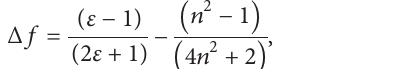
Figure 8: Plot of pH versus log [(A marin 3 in a 10% aqueous ethanolic-universal buffer solution, which is most pronounced at a pH of 6. Absorbance at 402nm was